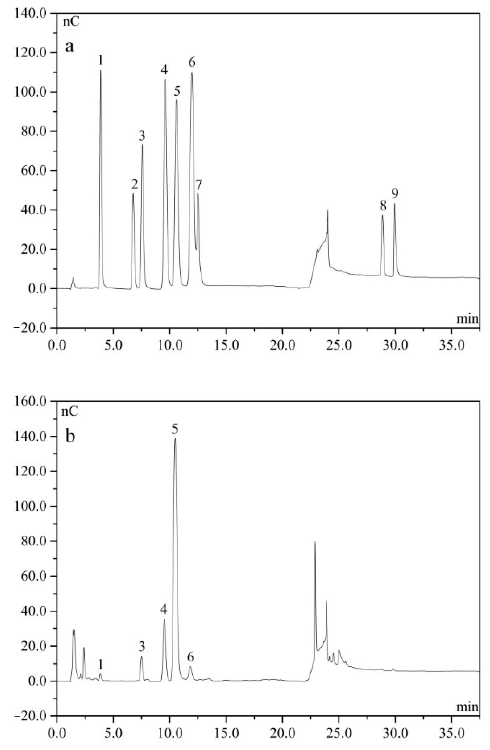
Figure 3. Ion chromatograms of standard monosaccharide ( a ) and cAMPs-1A ( b ). Peak identity: